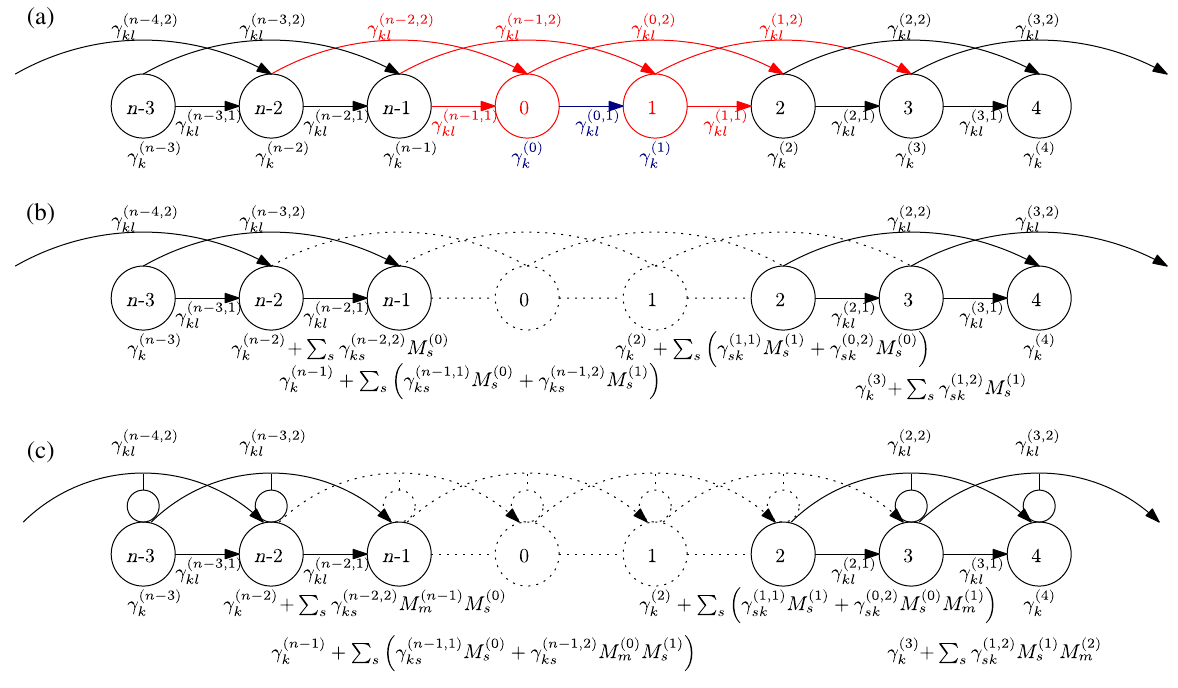
FIG. 9. In (a), we have a two-body Bell inequality with R ¼ 2 and PBC. The coefficients below the circles correspond to the weights of the one-body correlators associated to those parties, and the coefficients next to the arrows correspond to the weights of the correlators between the parties they join. In (b), we consider the intermediate case in which there are no observables M ð i Þ m in the middle of the string operators, whereas in (c) we include them [the big circles represent the set of observables labeled from 0 to m − 1 and the smaller circle represents the m th one [cf. Eq. (7)]. In order to transform it to an OBC case, we choose a deterministic local strategy for the parties labeled by 0 and 1. and we choose a deterministic local strategy for parties labeled by 0 and 1, represented in red in (a). Thus, the values of the one-body correlators from zeroth and first parties have a fixed value, as well as the two-body correlators between them. These are marked in blue. These terms ’ contribution represents an offset on the classical bound. The two-body correlators starting at n − 2 and ending at 0 are updated to the one-body terms of the ( n − 2 )th party. The correlators starting at n − 1 and ending either at 0 or 1 are updated to the one-body terms of the ( n − 1 )th party. Similarly, we update the one-body terms of parties 2 and 3. These terms are marked in red. The rest of the inequality remains untouched and such terms are marked in black. This process is the transformation from (a) to (b). Note that if the local deterministic strategy chosen in parties 0 and 1 is the optimal one, then the classical bound for the PBC problem is given by the offset generated by parties 0 and 1 (blue) plus the classical bound of the OBC problem between parties 2 and n − 1 . Since there is a finite number of deterministic local strategies that parties 0 and 1 can have, eventually we find the optimal bound for the PBC problem. Finally, in (c) we depict the same procedure, but some more assignments M ð i Þ m have to be fixed in advance to update the one- body terms